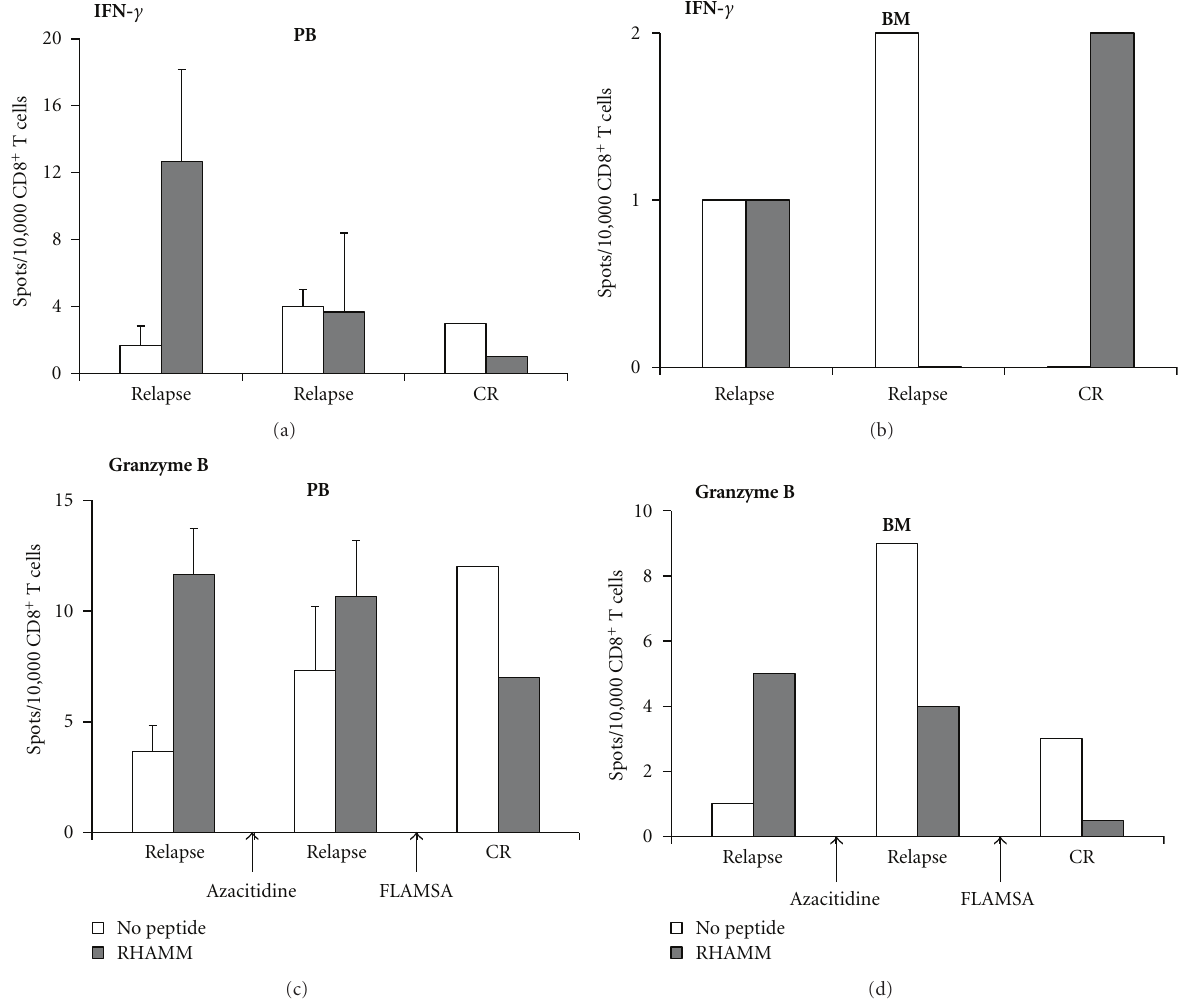
Figure 5: RHAMM-specific CTLs in a patient during relapse of AML. Release of both IFN- γ (upper panel) and granzyme B (lower panel) by RHAMM-specific CTLs was detected by ELISPOT in peripheral blood ((a), (b)) and bone marrow ((c), (d)) of a patient at the time of relapse. This population was lost following treatment with azacitidine and conditioning according to the FLAMSA protocol [6] followed by allo-SCT. Cells were not enough to perform flow cytometry analysis. Please note di ff erent y -axis scaling in this